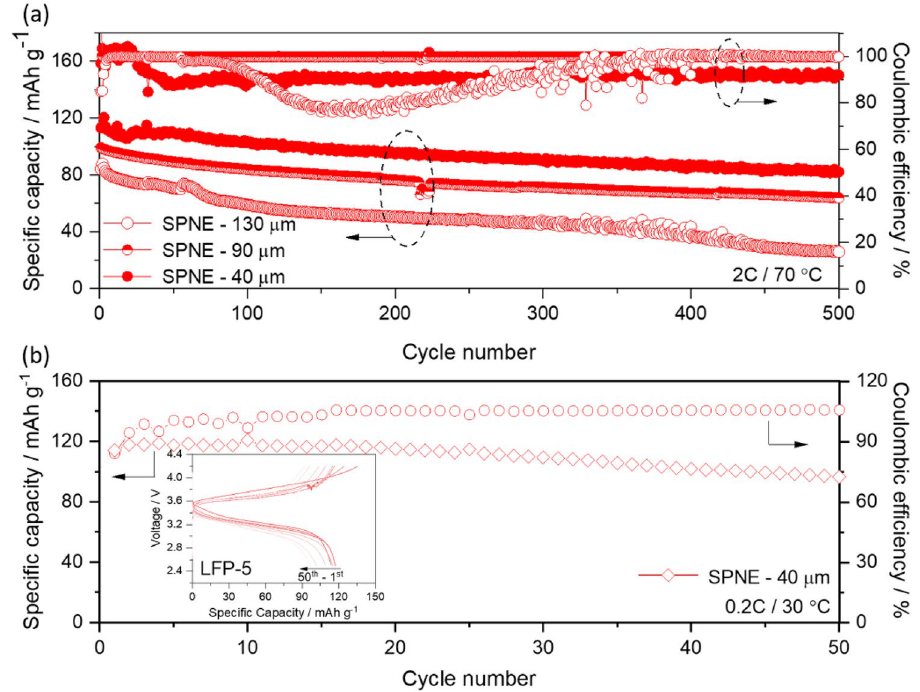
Figure 8. ( a ) Long-term cycle performance curve of Li/SPNE/LFP-5 cell with different thickness of SPNE (40, 90 and 130 µm) measured at 2C rate at 70 °C and ( b ) Cycle performance curve of the same cell measured at 0.2C rate at 30 °C with in-set of its charge/discharge curves for 40 µm thickness of SPNE.